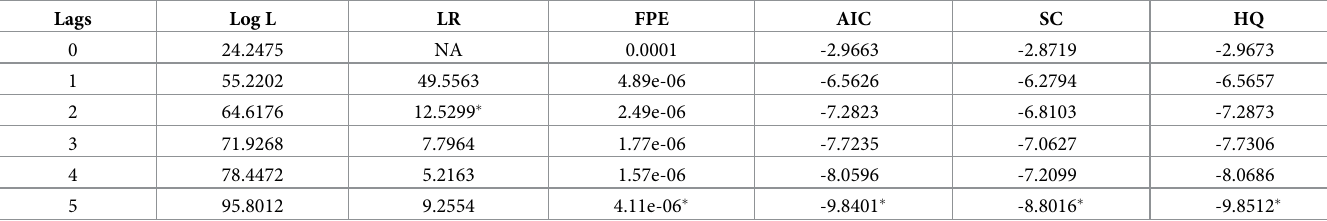
Table 9. Results of lag selection of internal R&D and S&T output VAR models with different criterions.